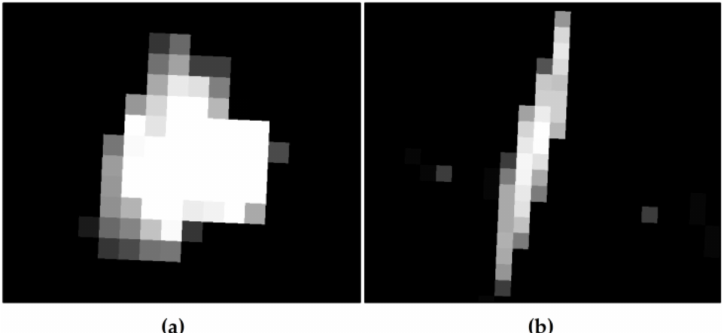
Figure 2. Shape results of the offshore platform and ship in the GF-3 synthetic aperture radar (SAR) image. ( a ) shows the offshore platform, and ( b ) shows the